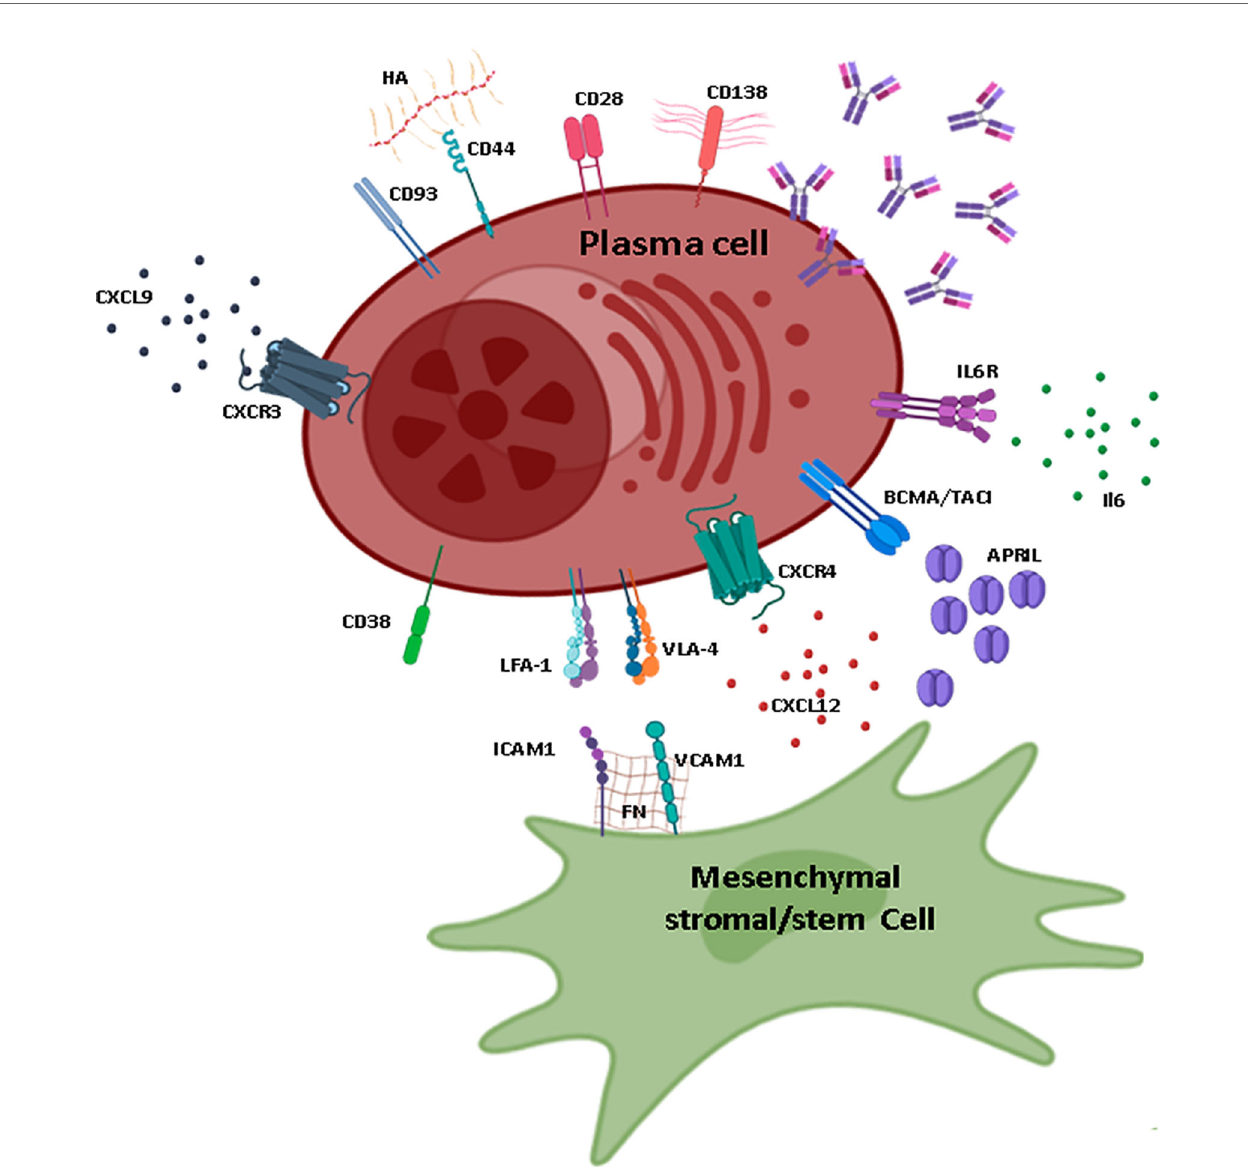
FIGURE 2 | Plasma cell maintenance in the BM. Schematic representation of the main elements necessary for plasma cell (PC) maintenance in the BM, mainly provided by interactions with MSCs. MSCs that sustain PC maintenance are characterized by the production of CXCL12 and are probably CXCL12-abundant reticular cells or PSS subpopulations. MSCs express VCAM-1 and FN that interact with VLA-4 and LFA-1. The main sources of APRIL and IL-6 are cells of myeloid lineage (especially megakaryocytes and eosinophils for APRIL and megakaryocytes, granulocytes, and eosinophils for IL-6). The ligands for CD38 and CD28 are expressed by other cell types and are not represented on this fi gure. The ligand of CD93 is unknown; however, this adhesion molecule is essential for the maintenance of long-lived PCs. CXCL9, one of the ligands of CXCR3, is produced by osteoblasts. CD138 is one of the main markers for PCs and is characterized by long heparan sulfate chains that trap molecules and allow interactions with the extracellular matrix. HA, hyaluronic acid; FN, fi bronectin; IL, interleukin; ILR, interleukin receptor. Figure created using the BioRender icon